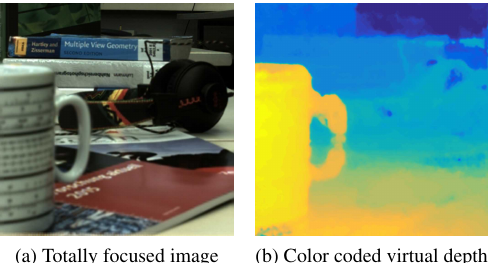
Figure 7. Sample scene recorded with focal length f L = 35 mm used for qualitative evaluation.